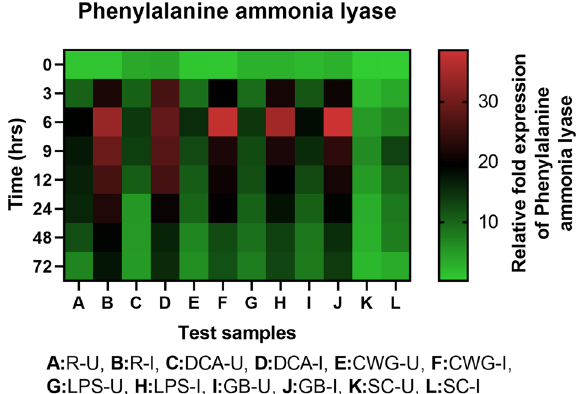
Figure 7. qRT-PCR determined relative expression of PAL genes in 2-day-old P. glaucum seedlings with (I) or without (U) Sclerospora graminicola inoculation harvested 0, 3, 6, 9, 12, 24, 48, and 72 h. R—resistant, S— susceptible, DCA—3,5-Dichloroanthranilic acid treated, CWG—Cell Wall Glucans isolated from the endophyte Trichoderma hamatum UOM 13, LPS—Lipopolysaccharides isolated from bacteria Pseudomonas fluorescens UOM 14, GB—Glycinebetaine an amino acid derivative. Expression levels were measured by qPCR and normalized to the constitutive PP2A gene. Values are means of experiments carried out in four replicates. The bars indicate ± SE and the data were analyzed by one-way ANOVA followed by Tukey’s test and p ≤ 0.05.